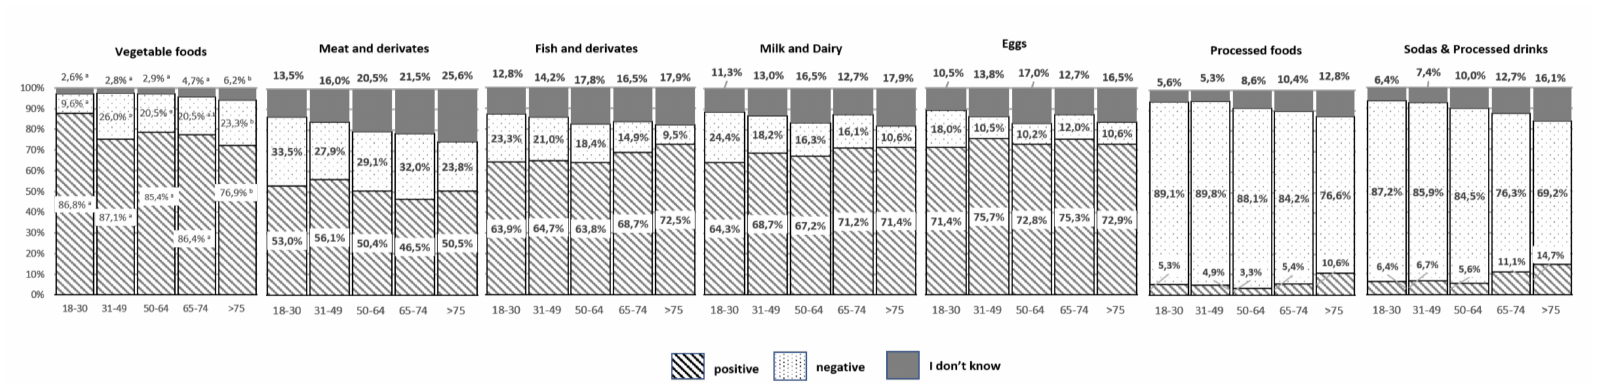
Figure 4. Perceived impact on sustainability of the di ff erent food groups in Spanish adult population, by age groups. Di ff erent letter superscripts denote statistical di ff erences ( p ≤ 0.05) between age groups. Samples size were 18–30 years n = 266; 31–49 years n = 675; 50–64 years n = 522; 65–74 years n = 316; > 75 years n =